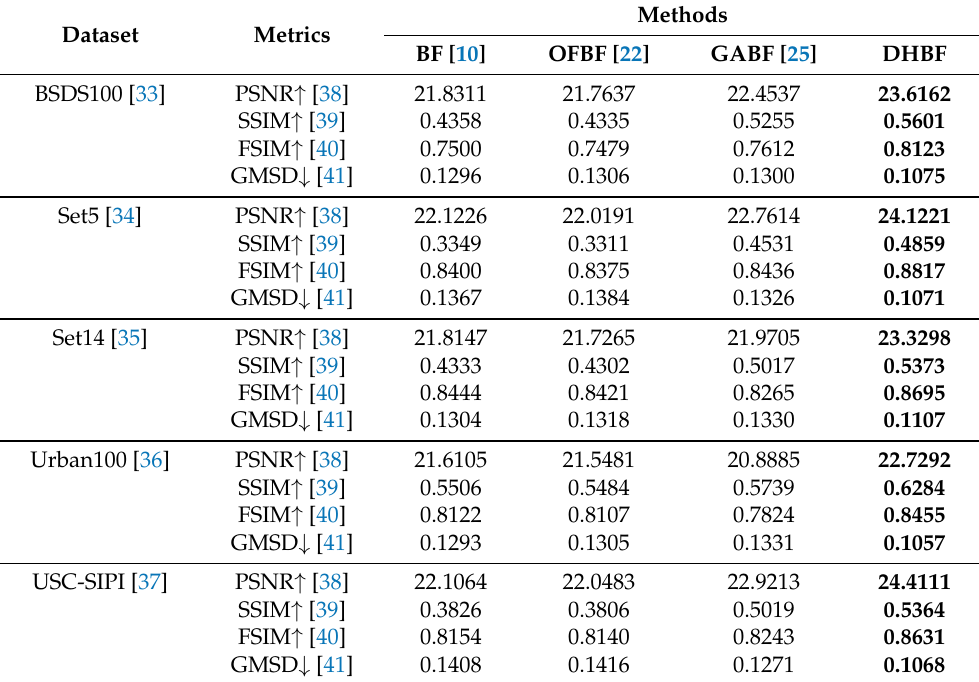
Table 1. Full-reference Image Quality Assessment for different methods. The best scores are in